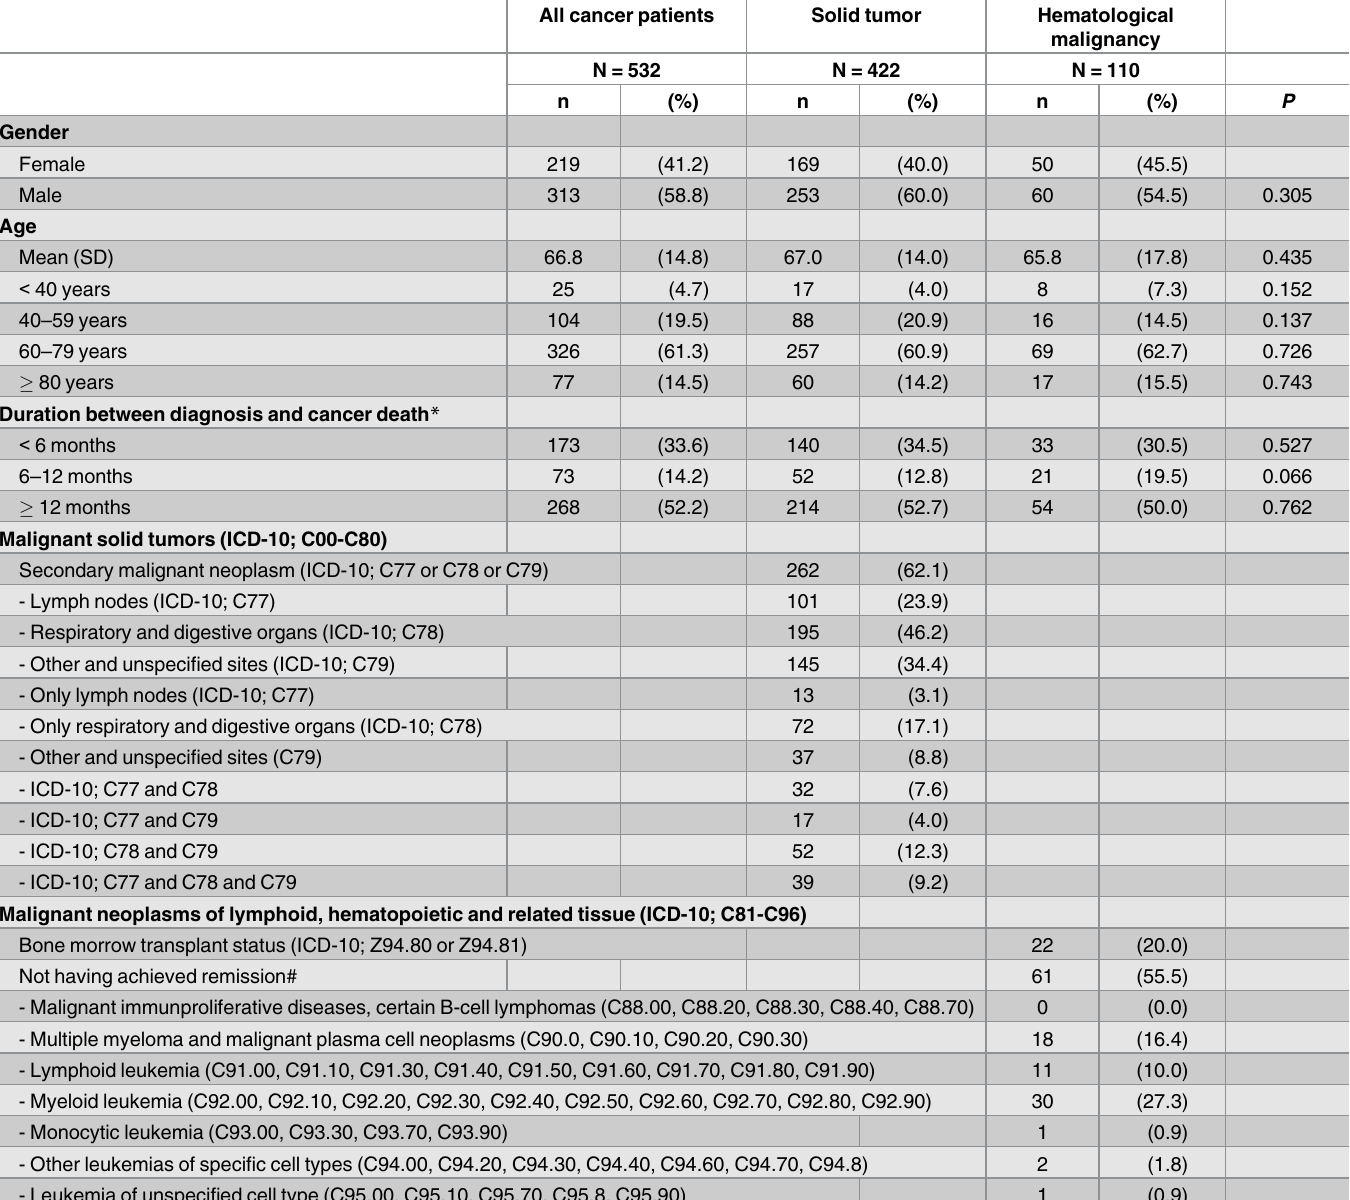
Table 1. Characteristics of deceasedcancer patients.